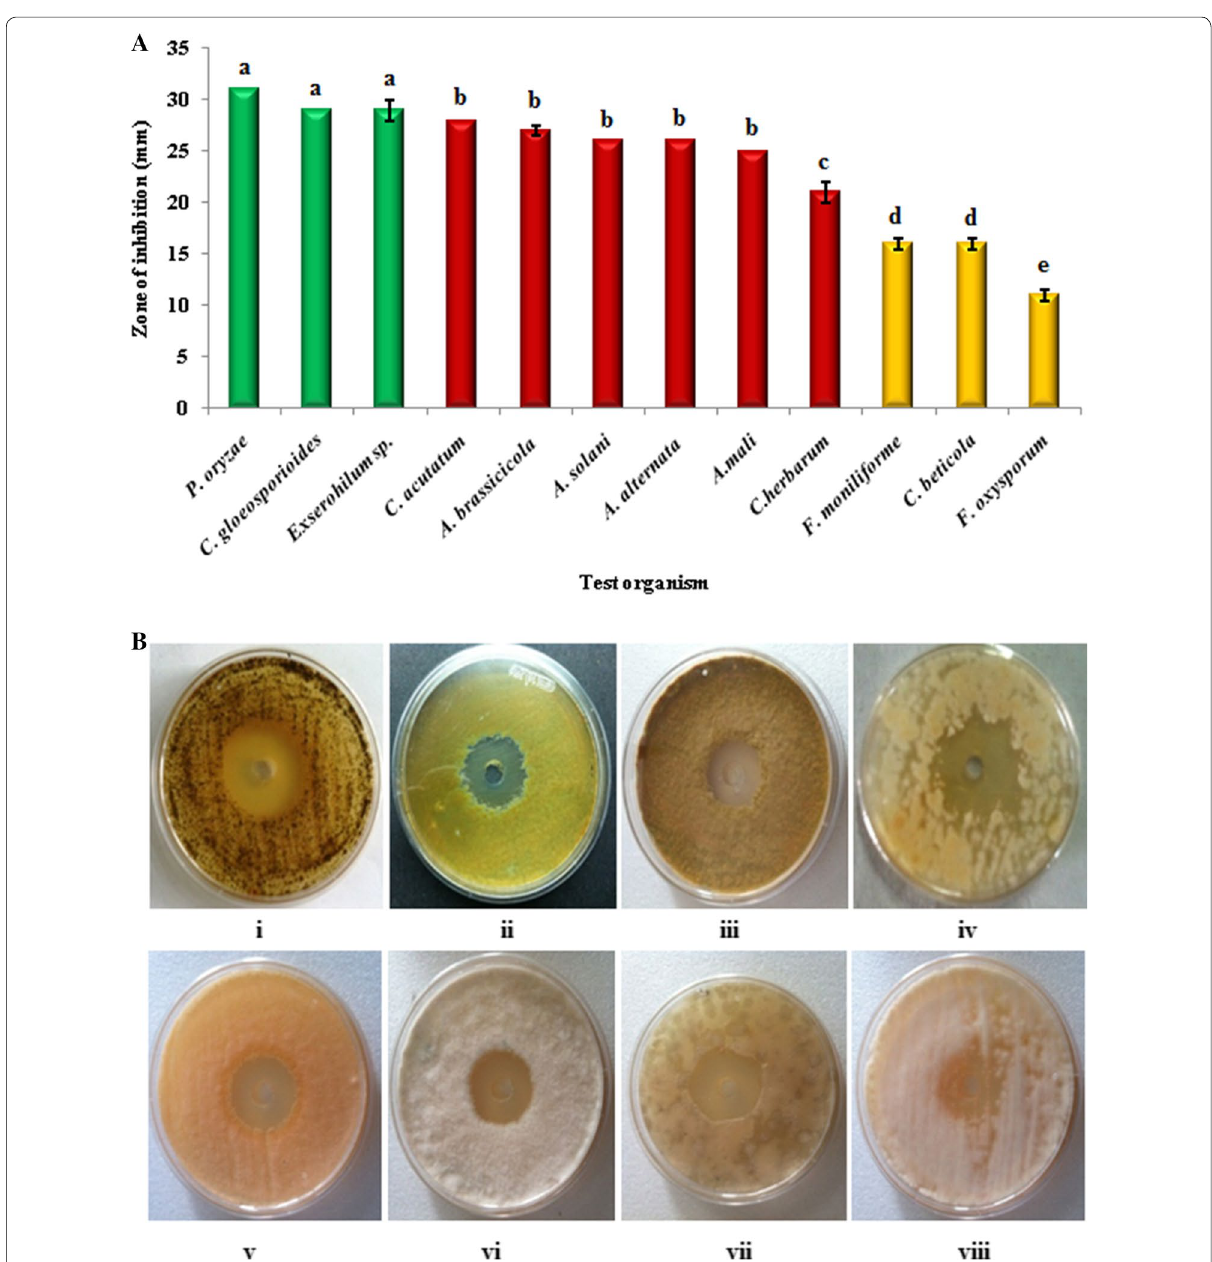
Fig. 5 A Antifungal activity of Streptomyces sp. MR14 against different fungal phytopathogens; bars with different letters are statistically different (Tukey’s HSD, p 0.05). B The clear zones around the wells showing antifungal activity of Streptomyces sp. MR14 by well diffusion method against (i) ≤ A. brassicicola (ii) A. mali (iii) A. alternata (iv) A. solani (v) C. acutatum (vi) C. gloeosporioides (vii) Exserohilum sp. (viii) F.